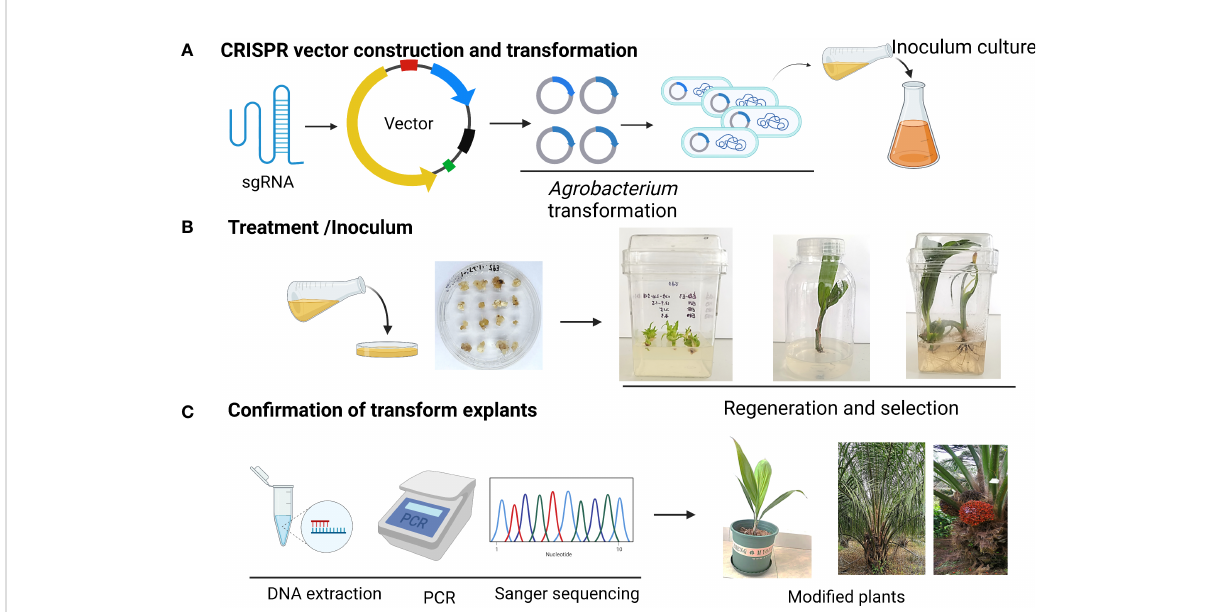
FIGURE 1 Schematic representation of CRISPR/Cas9 vector delivery tissue culture and selection strategy for genome-edited palm. (A) CRISPR vector construction and transformation (B) Treatment and infection to explants (C) Con fi rmation of positive